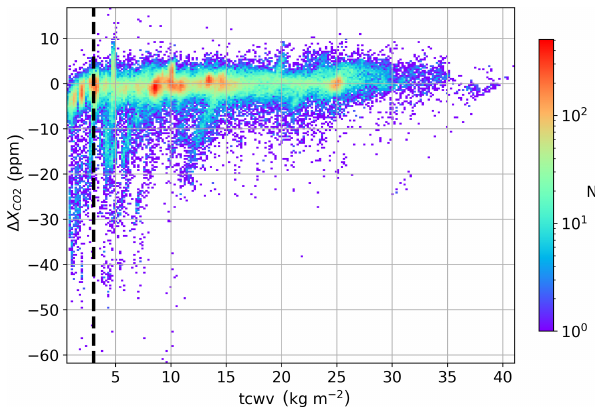
≡ OCO-2 ( (cid:49)X CO Figure 22. Bias in coincident retrievals of X CO 2 2 2 – NNG), with no QC filtering against a priori tcwv (total column water vapor), plotted as a density map. A priori tcwv is defined by ECMWF reanalysis data. The lower bound placed on tcwv in the boreal QC (3kgm − 2 ) is shown as a black dashed vertical line.